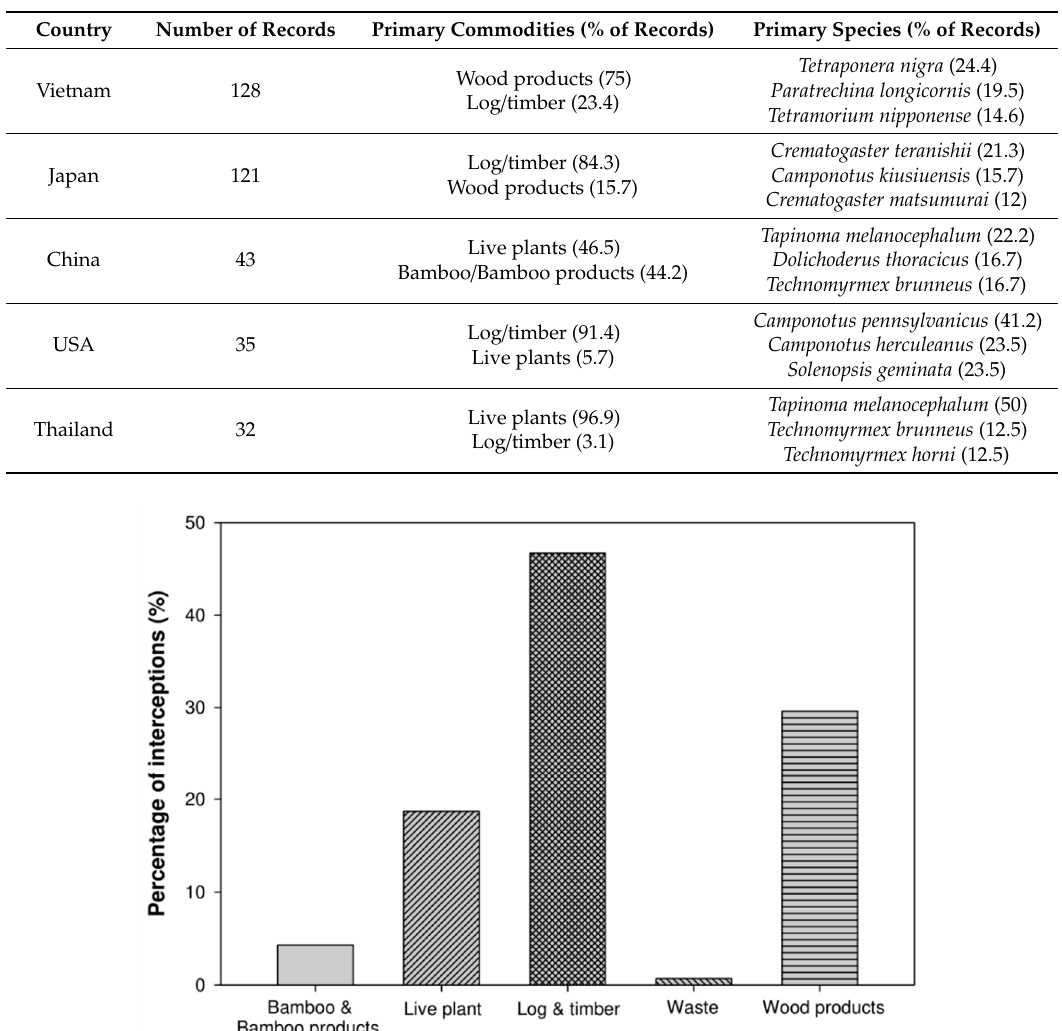
Table 2. Top five countries of origin ranked by number of ant interceptions, and the primary commodity type and ant species for each respective country.